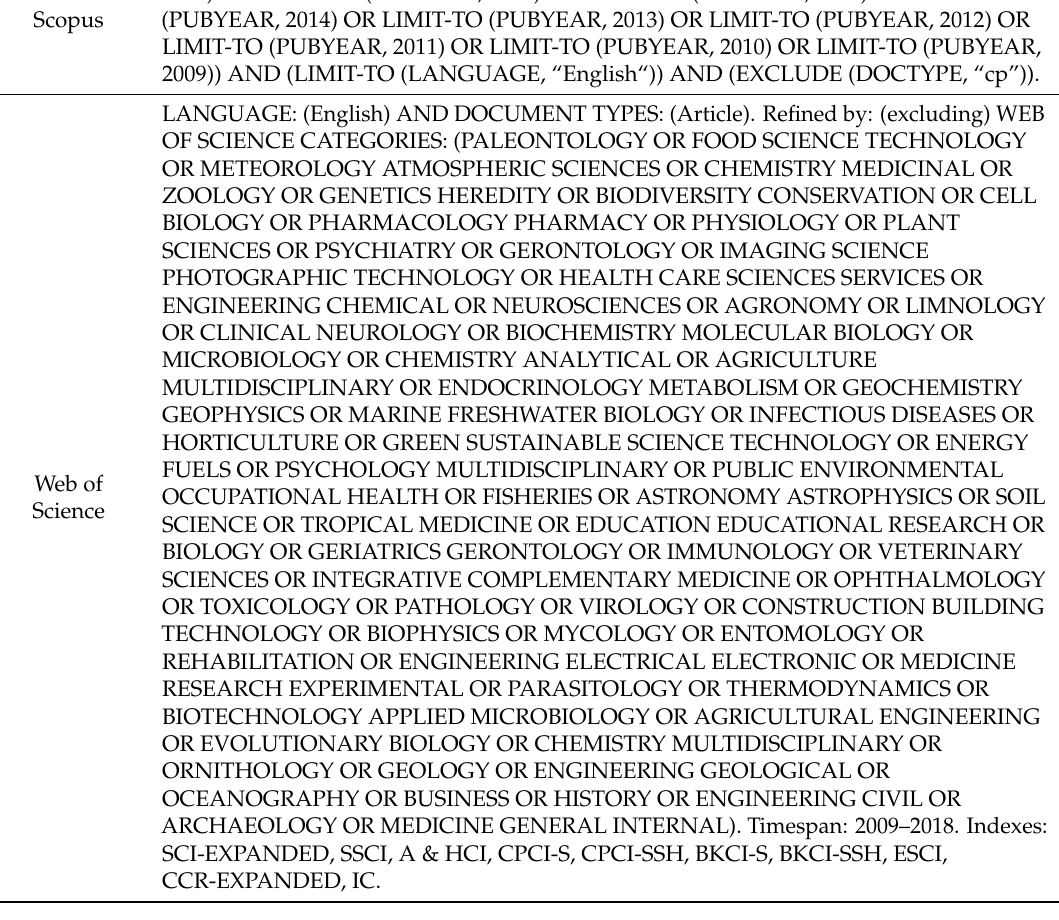
Table A2. Additional conditions for searches in Scopus and Web of Science. Database Conditions